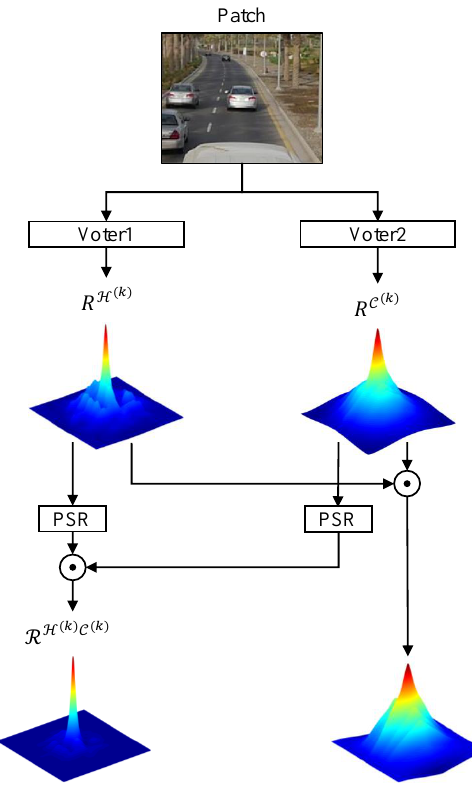
Figure 7. Fused response map differences with and without PSR-based